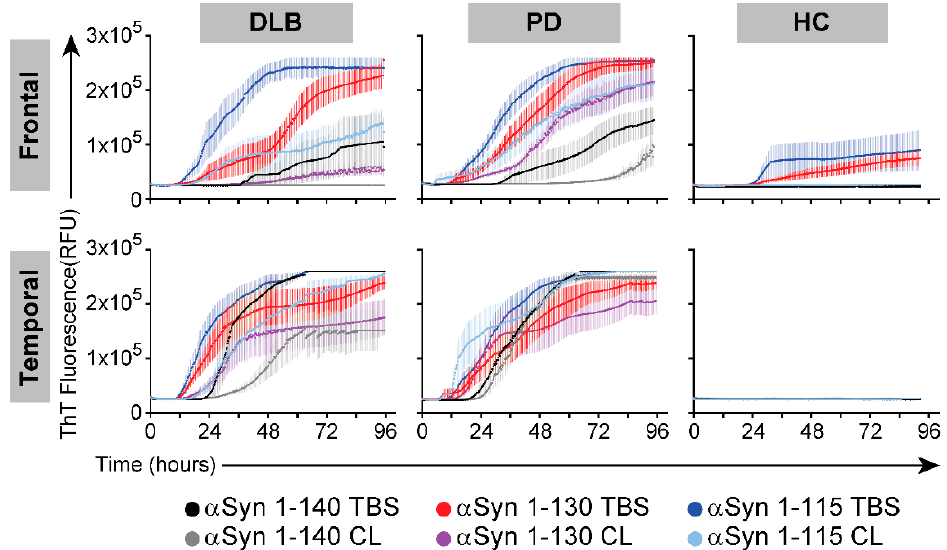
Figure 2. RT ‐ QuIC assays with recombinant α Syn forms in RT ‐ QuIC using brain homogenates from Figure 2. RT-QuIC assays with recombinant α Syn forms in RT-QuIC using brain homogenates from PD and DLB cases. PD and DLB cases. Aqueous ‐ soluble and detergent ‐ soluble (CelLytic, CL) fractions were prepared Aqueous-soluble and detergent-soluble (CelLytic, CL) fractions were prepared from the temporal and frontal cortices of from the temporal and frontal cortices of 8 cases of DLB, PD, or healthy controls (HC), then assayed 8 cases of DLB, PD, or healthy controls (HC), then assayed by RT-QuIC using three α Syn forms (full length 1-140 and by RT ‐ QuIC using three α Syn forms (full length 1 ‐ 140 and truncated forms 1 ‐ 130 or 1 ‐ 115) as de ‐ truncated forms 1-130 or 1-115) as described in Section 2. Data shown are the averages ( ± SEM) of ThT signal (relative scribed in Section 2. Data shown are the averages (± SEM) of ThT signal (relative fluorescence units, fluorescence units, RFU) over RFU) over time.